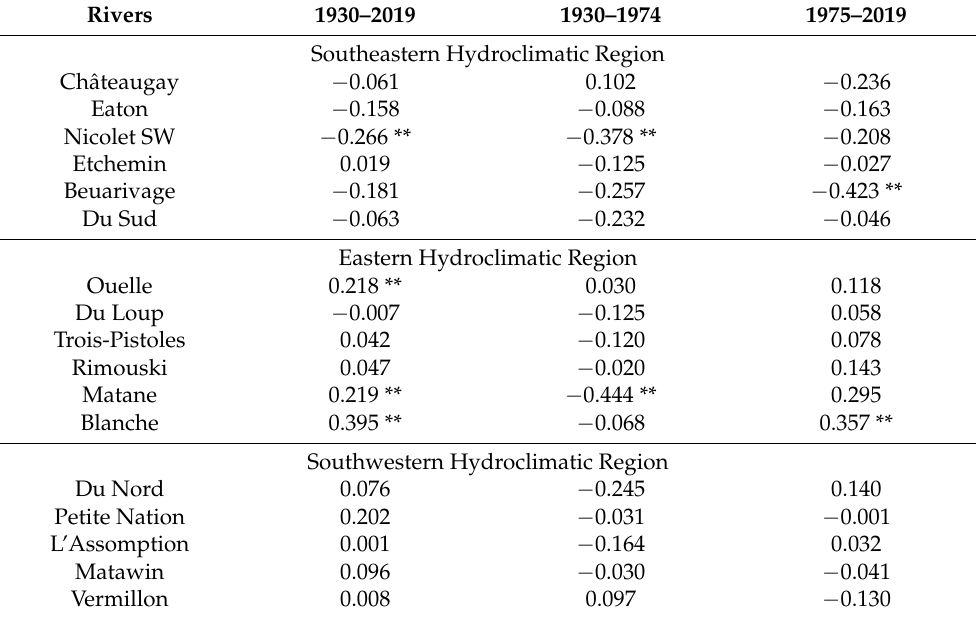
Table 6. Correlation coefficients calculated between the winter and spring daily maximum flows for three